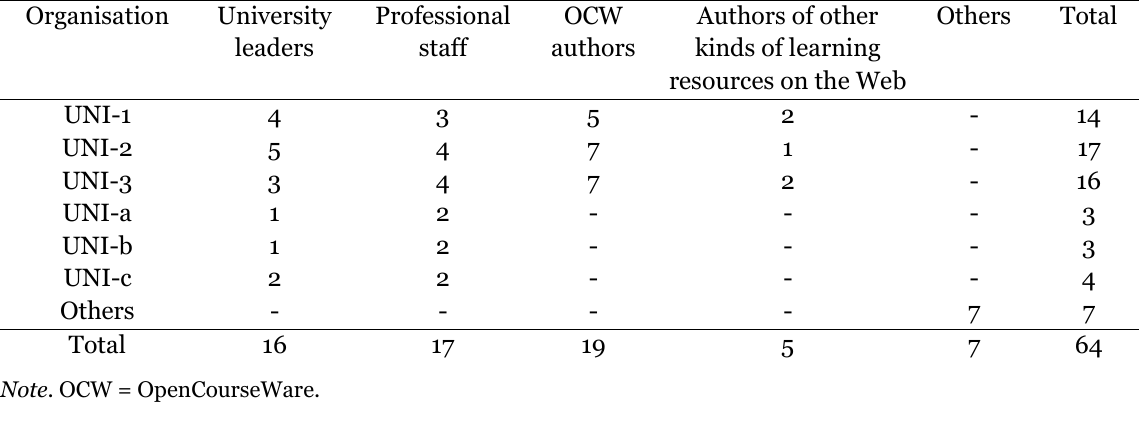
Table 1 Research Participants per Setting and Category